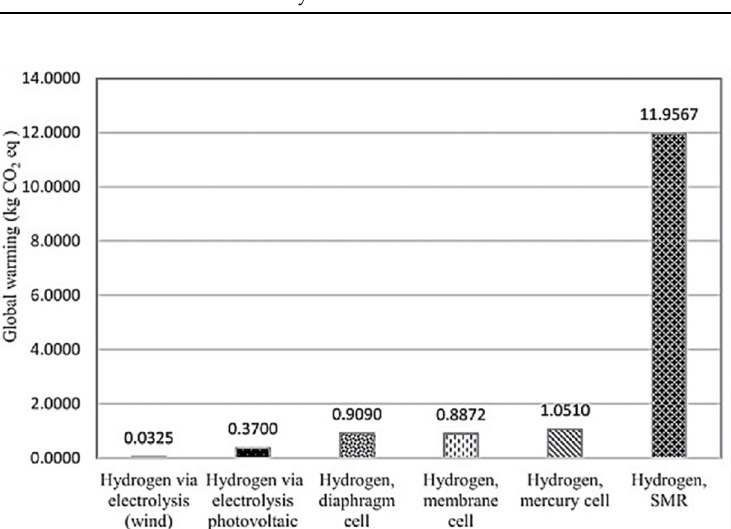
Figure 9. The comparison of various methods of hydrogen production in terms of cost (USD/kg) and their environmental impacts (kg CO 2 eq). Reprinted with permission [28,57]. Table 6. Various hydrogen production processes and their sources (feedstocks and energy) and cost per kg of hydrogen. Reprinted with permission [28,57].